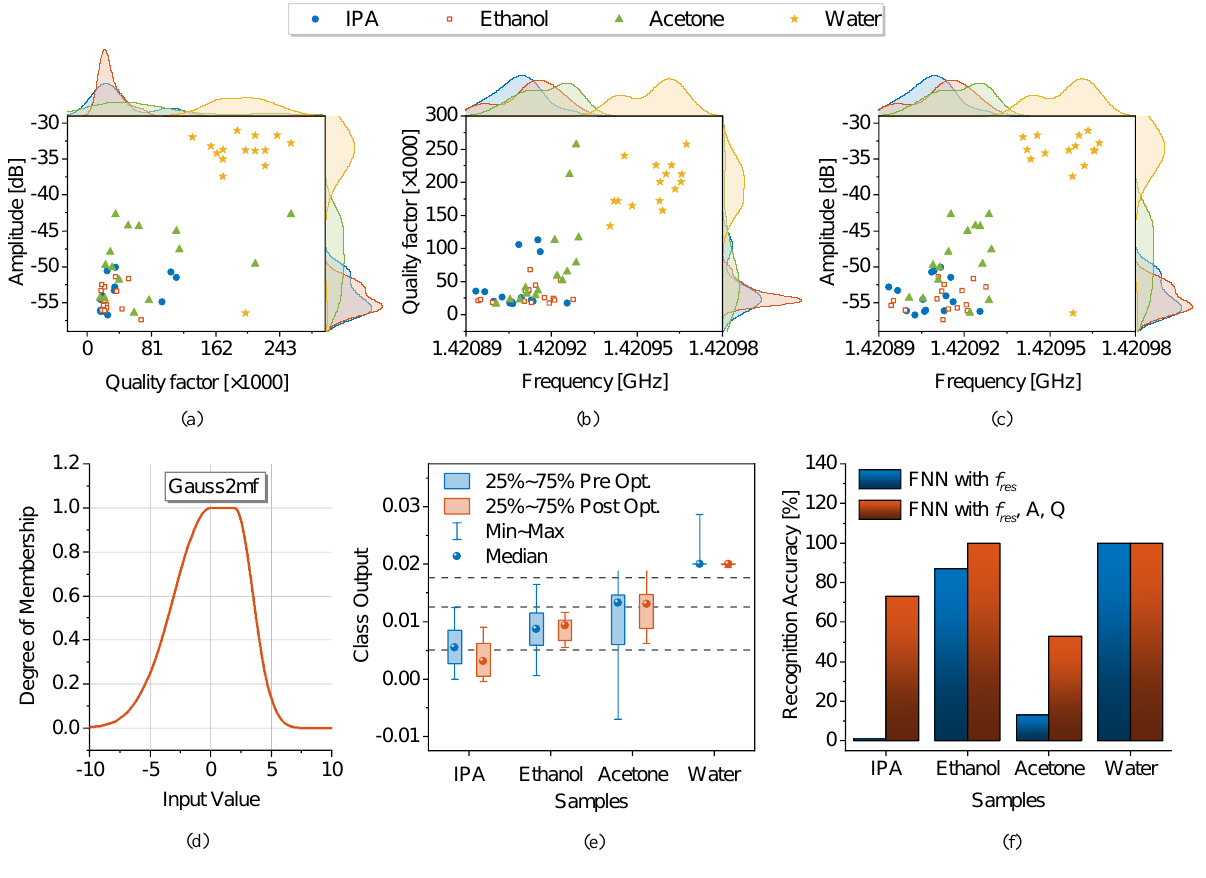
Figure 44. Sensor response for various MUT location and classification results. Sensor response comparison exposed to IPA, ethanol, acetone, and water between ( a ) Amplitude and Q-factor, ( b ) Q- factor and frequency, ( c ) Amplitude and frequency. ( d ) Gaussian membership function in Fuzzy neural network example, ( e ) Sample classification results without (blue) and with (red) optimization, ( f ) Comparing common MUT recognition accuracy when only f res is used as apposed to incorporating all f res , A , and Q . Reprinted with permission from Ref.